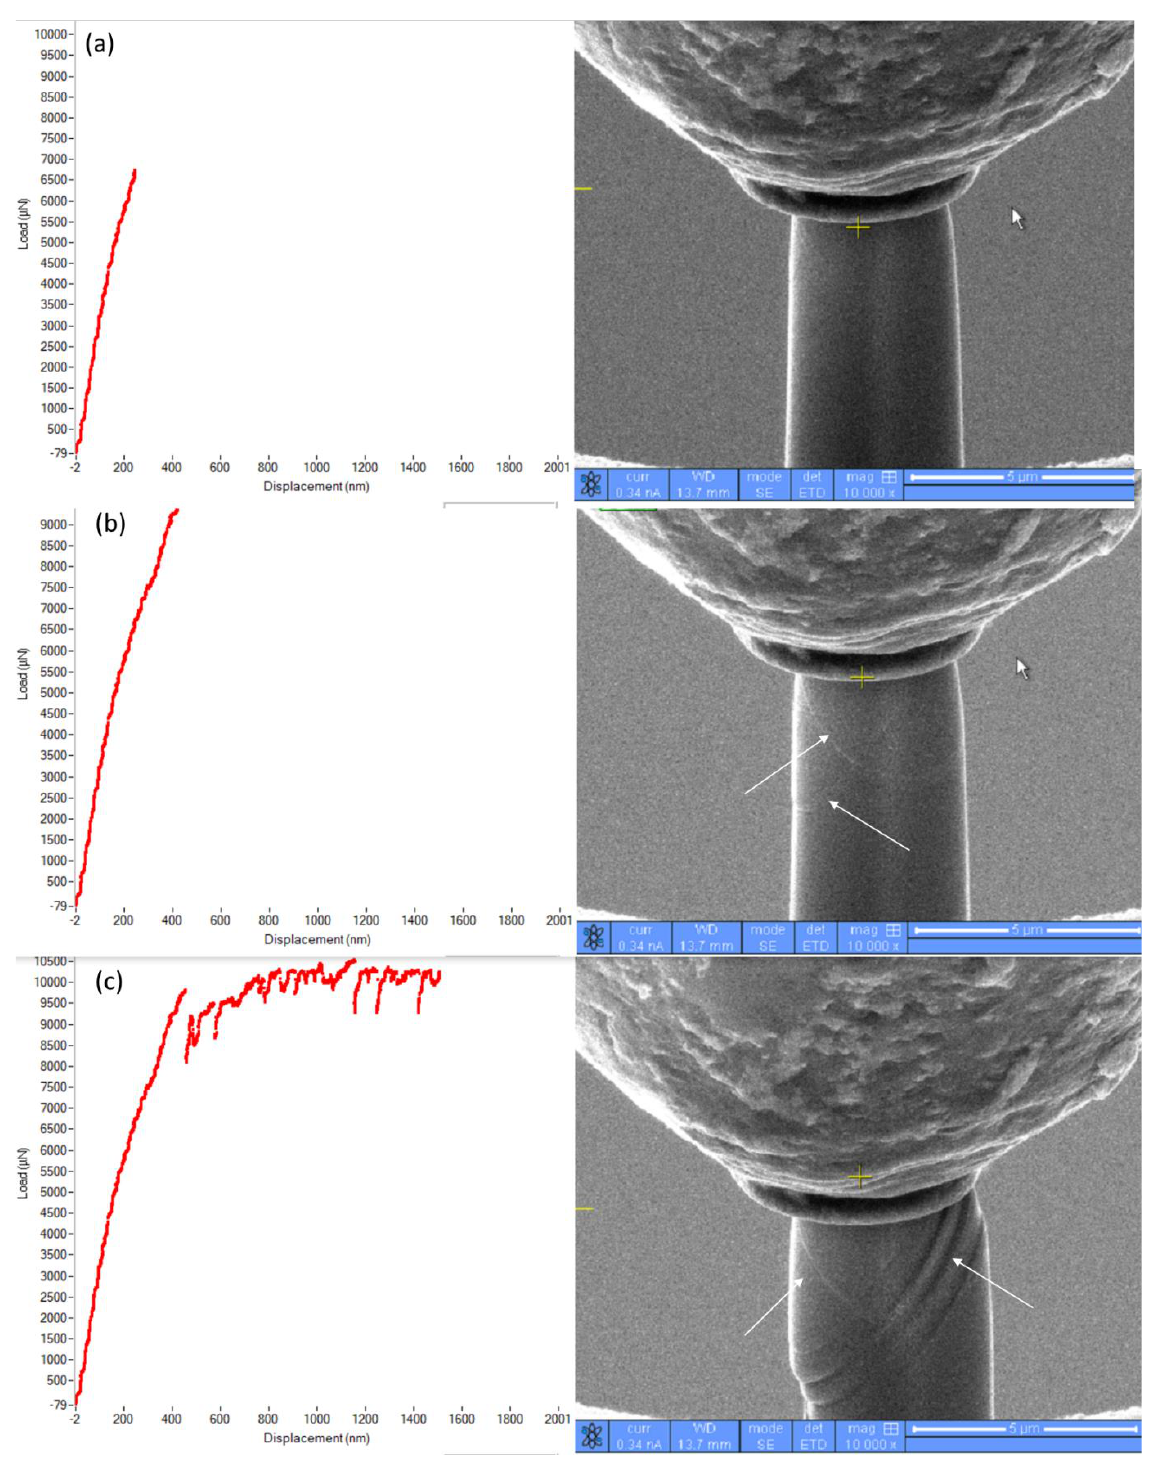
Figure 7. State of the micro-pillar at different strain intervals in the course of compression: ( a ) 1%, ( b ) 3%, and ( c ) 10% strain. ( b ) 3%, and ( c ) 10%